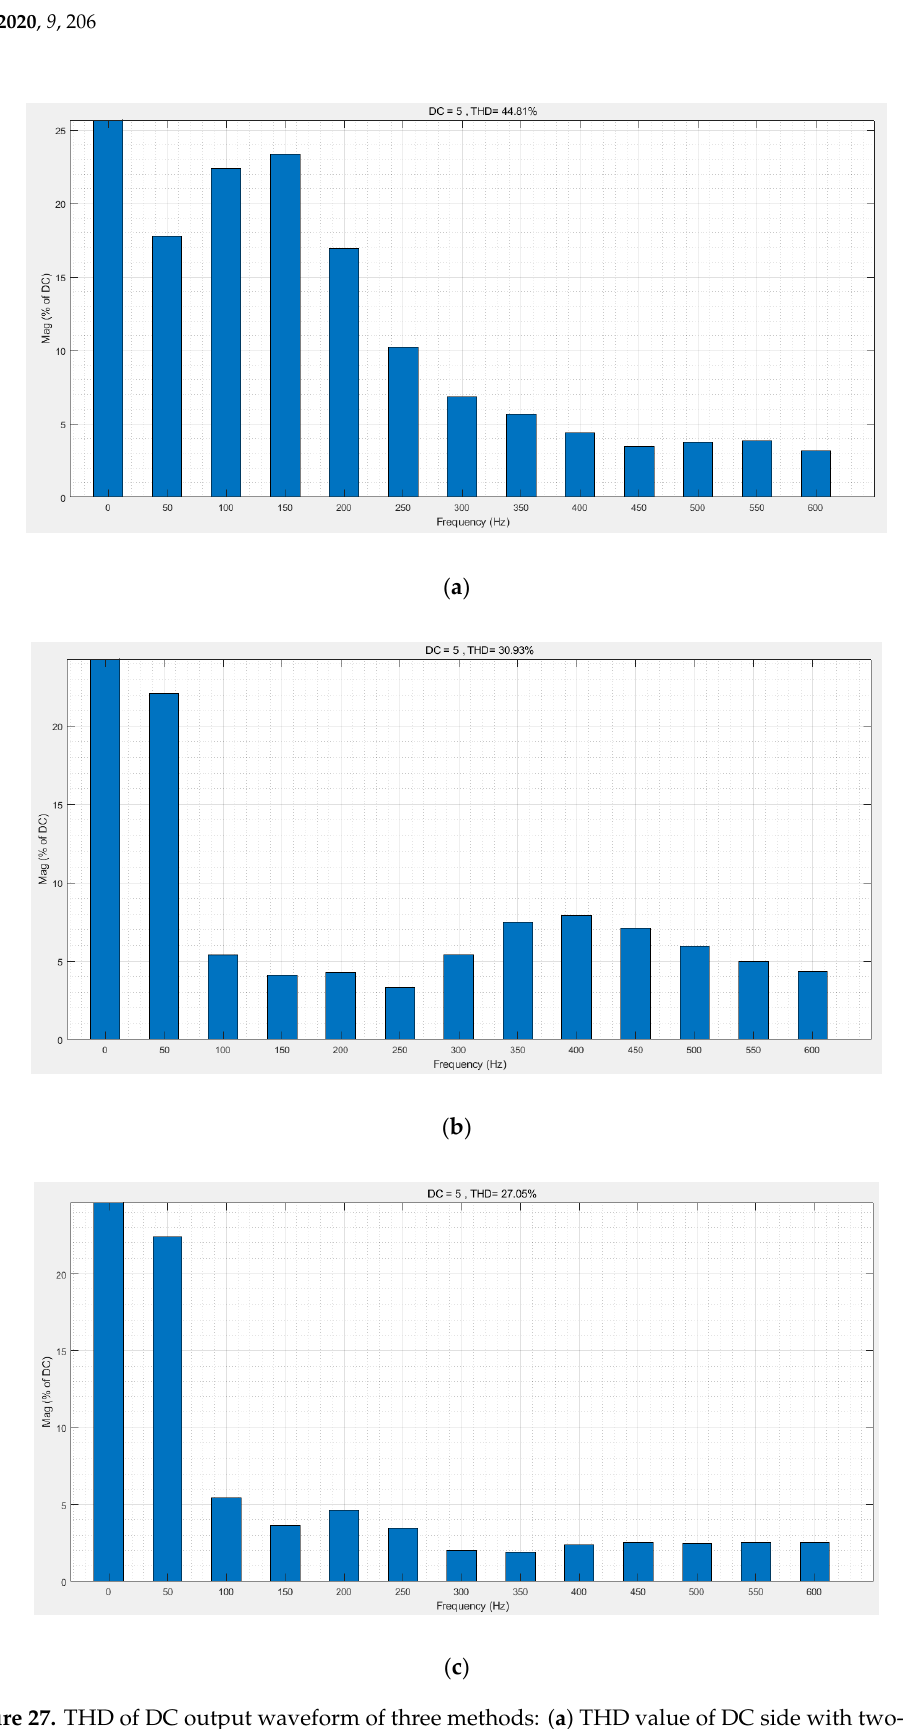
Figure 27. THD of DC output waveform of three methods: ( a ) THD value of DC side with two-stage EMI filter; ( b ) THD value of DC side after using spread spectrum technology; ( c ) THD value of DC side after adopting three-phase four bridge